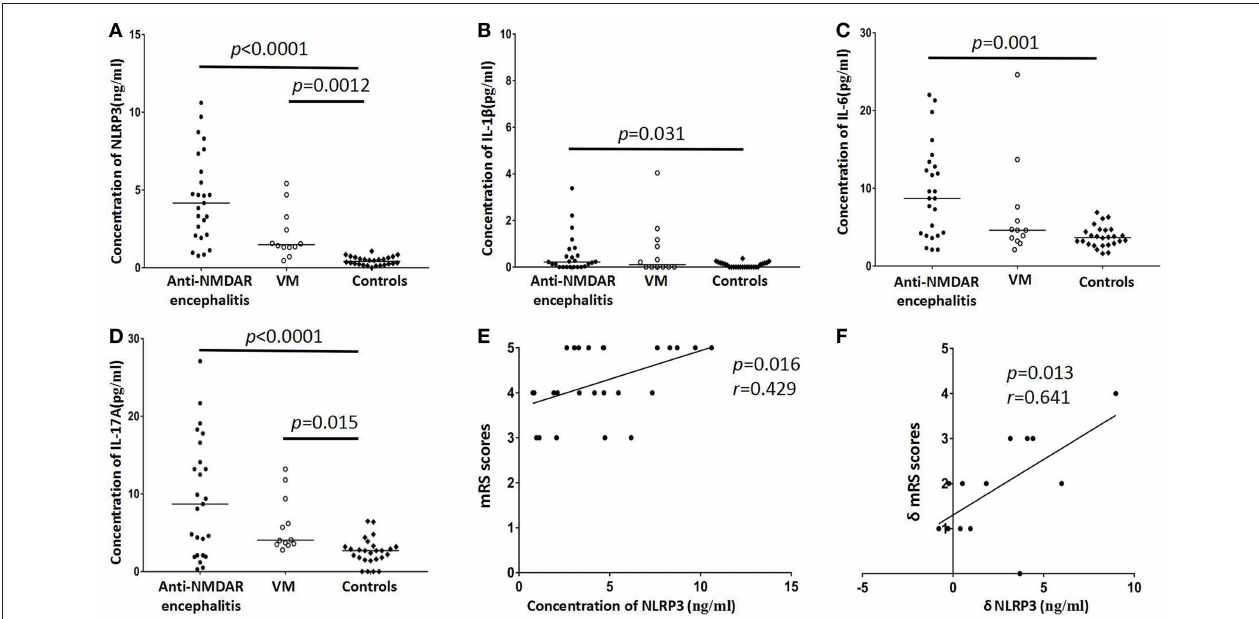
FIGURE 1 | Distribution of CSF NLRP3 inflammasomes and cytokines levels in anti-NMDAR encephalitis patients and controls groups [viral meningoencephalitis (VM) and non-inflammatory neurological diseases (Controls)]. Higher levels of CSF NLRP3 inflammasomes were found in anti-NMDAR encephalitis and VM patients (A) . CSF IL-1 β levels of anti-NMDAR encephalitis patients had significant difference with controls (B) . CSF levels of IL-6 showed elevated in patients with anti-NMDAR encephalitis (C) . The levels of IL-17 were also significantly changed in anti-NMDAR encephalitis and VM patients (D) . The correlation between mRS score and CSF NLRP3 inflammasomes in anti-NMDAR encephalitis patients in acute stage (E) . The correlation between the δ mRS and the decrease of CSF NLRP3 inflammasomes in patients with anti-NMDAR encephalitis in follow-up period (F) . The p -values and r values were indicated within figures. (mRS, modified Rankin Scale; VM, viral